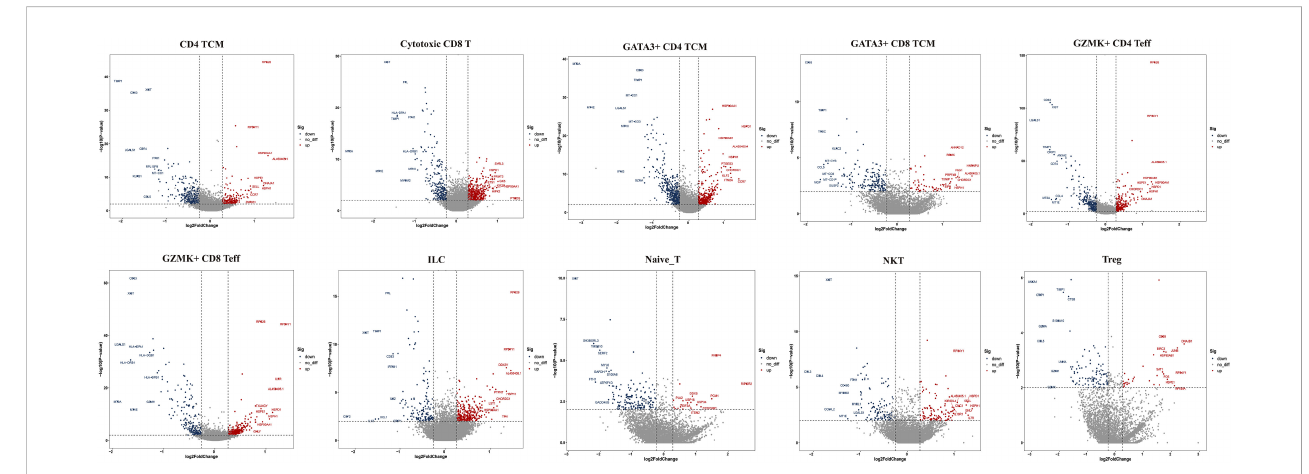
FIGURE 4 Top 10 differentially expressed genes (DEGs) of T cell subclusters. TCM, central memory T cell; Teff, effector T cell; Treg, regulator T cell; ILC, innate lymphoid cells; NKT, nature killer T